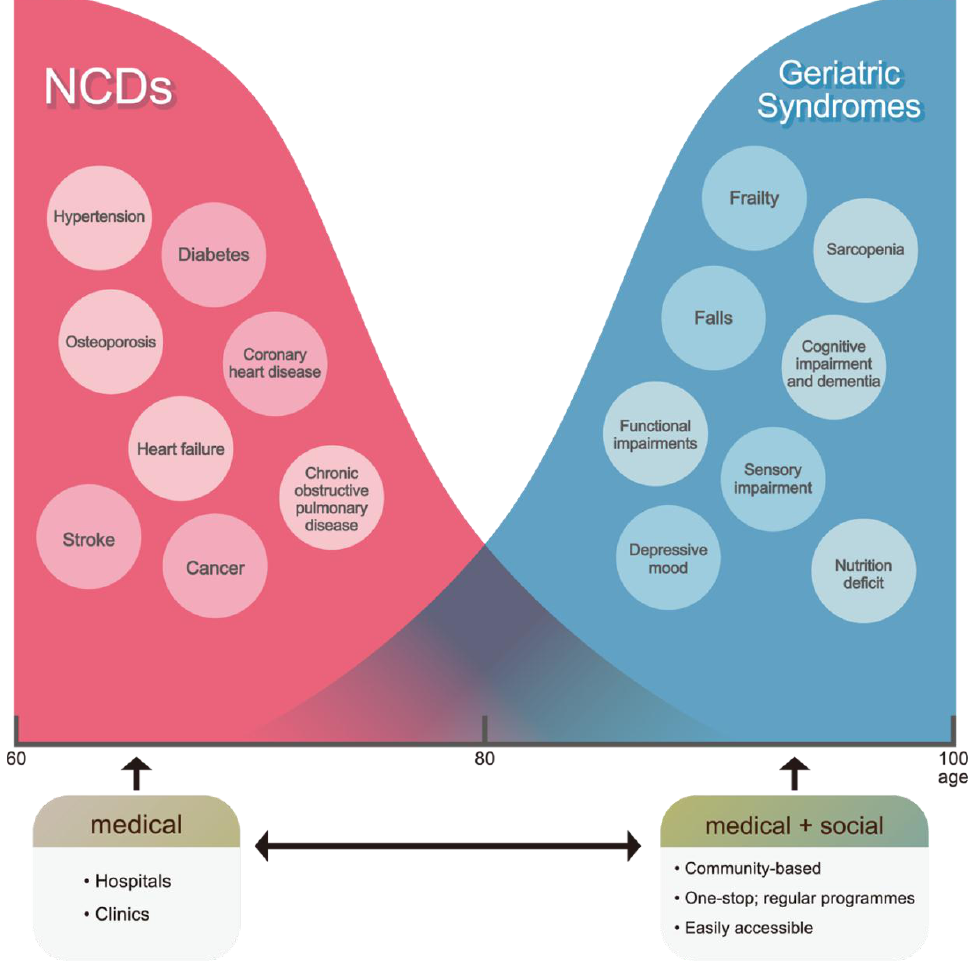
Figure 1. Non-communicable diseases (NCD) and frailty.